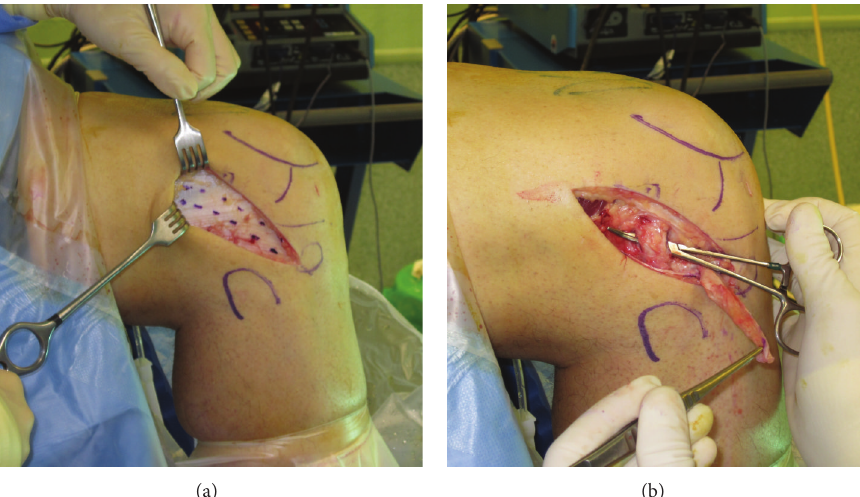
Figure 3: Lateral approach. The graft is designed on the ITB measuring 8–10cm × 1cm (a). The space under the LCL is developed, and the graft will be passed under it (b).